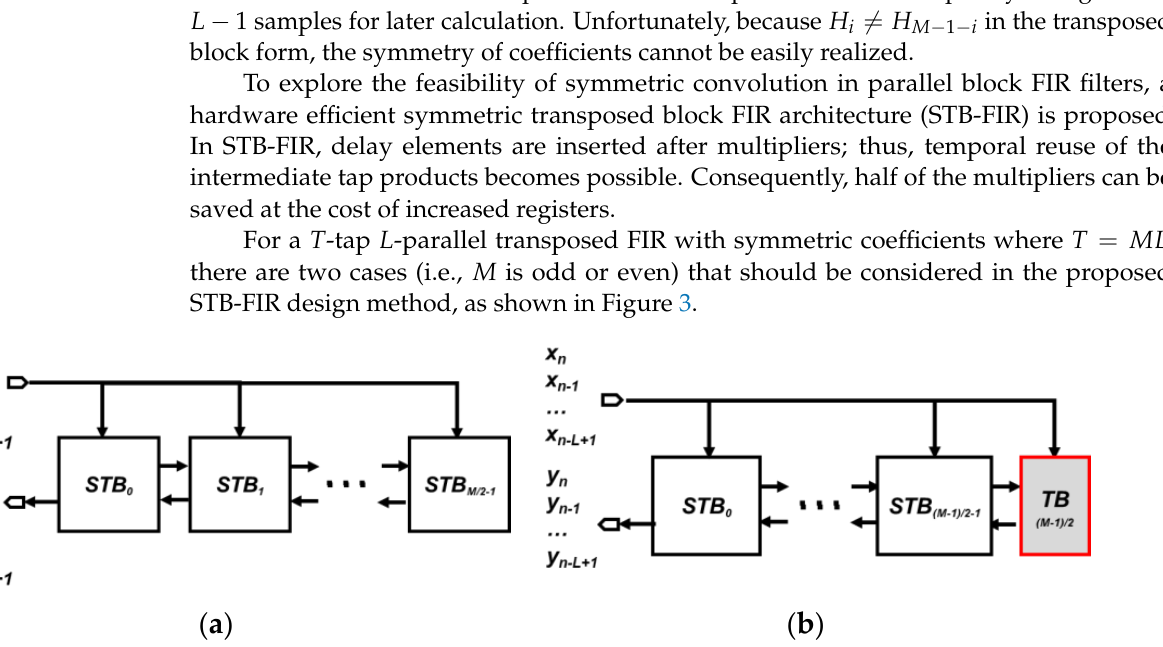
Figure 3. Proposed STB-FIR structure with two cases: ( a ) TB-based fully symmetric folded structure when 𝑀 is even and ( b ) non-symmetric folded structure when 𝑀 is odd.